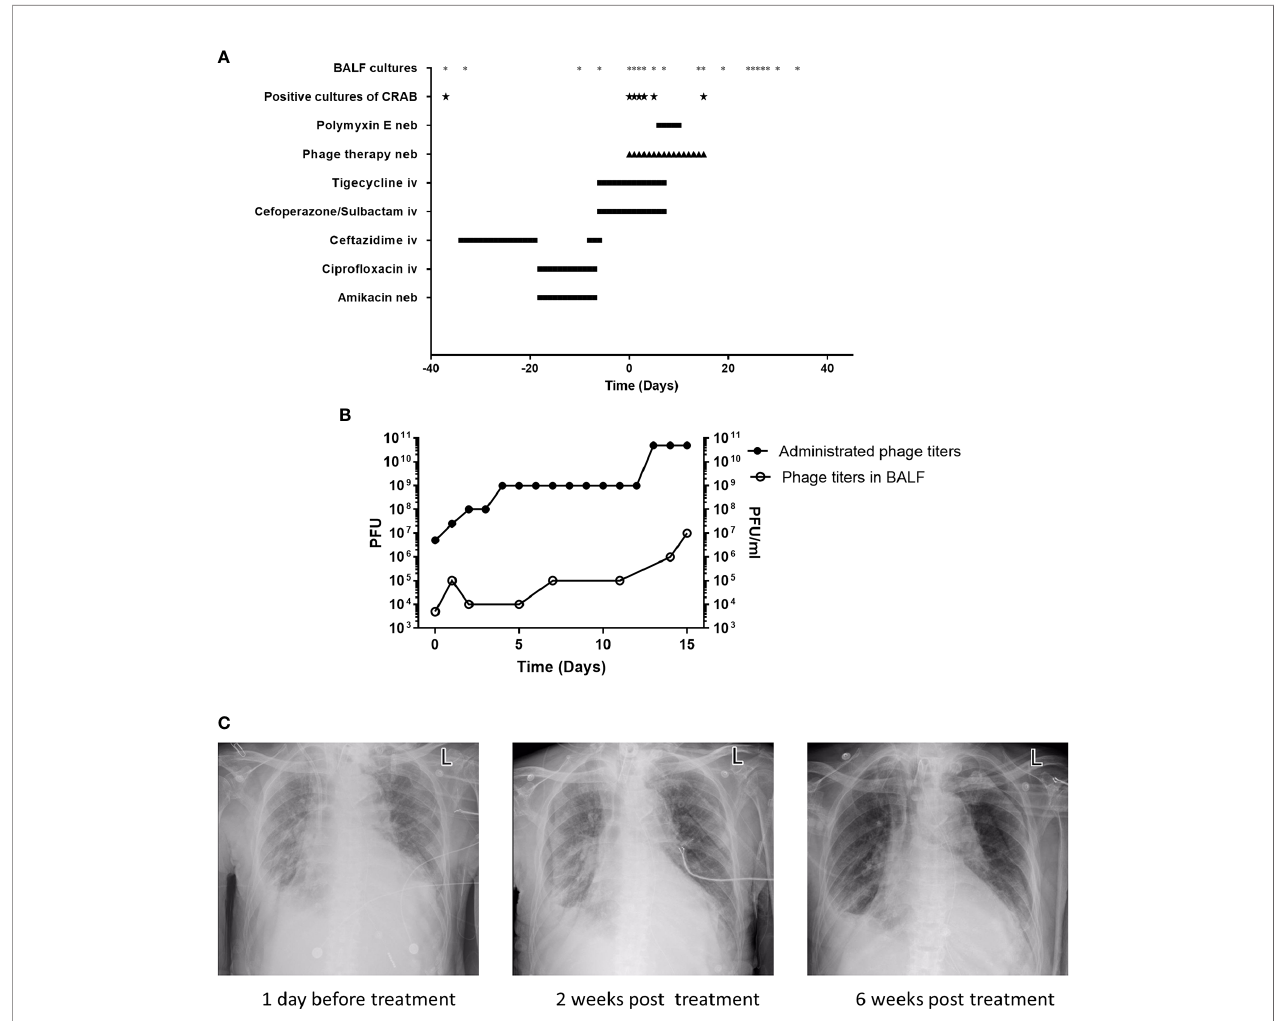
FIGURE 1 | Patient clinical data in phage therapy. (A) Timeline of bronchoalveolar lavage fl uid (BALF) cultures, drug, and phage administration. BALF samples were collected as indicated (*), positive cultures of carbapenem-resistant A . baumannii (CRAB) have been marked ( ★ ). The timeline shows the administration of antibiotics and phage preparation, and the administration of drugs is indicated (day 0 indicates the time when phage therapy was initiated). Iv, intravenous; neb, nebulization. (B) Administrated phage titers and phage titers in BALF detected by plaque assays following the phage therapy. Left Y-axis represents the administrated phage titers and right Y-axis represents the phage titers in BALF. (C) Chest X-rays results on -1st day, 14th and 42nd day of phage treatment,